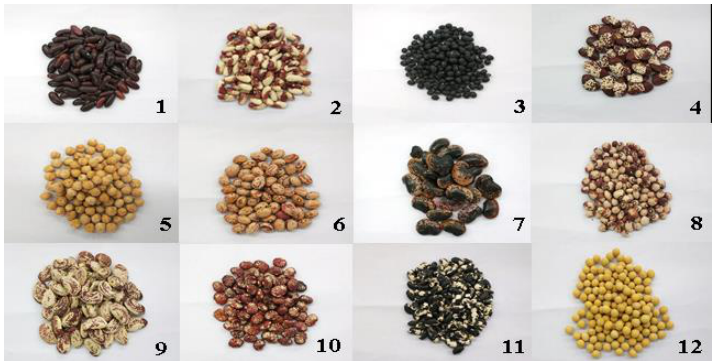
Figure 4. Representative photographs of twelve bean cultivars.